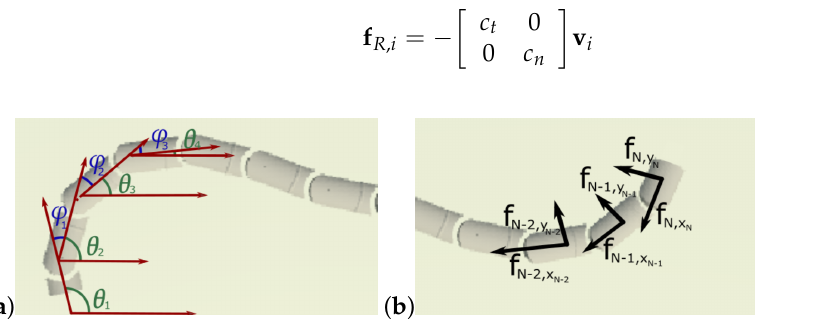
Figure 1. Assignment of ( a ) joint and link angles ( b ) friction force in the normal and tangential